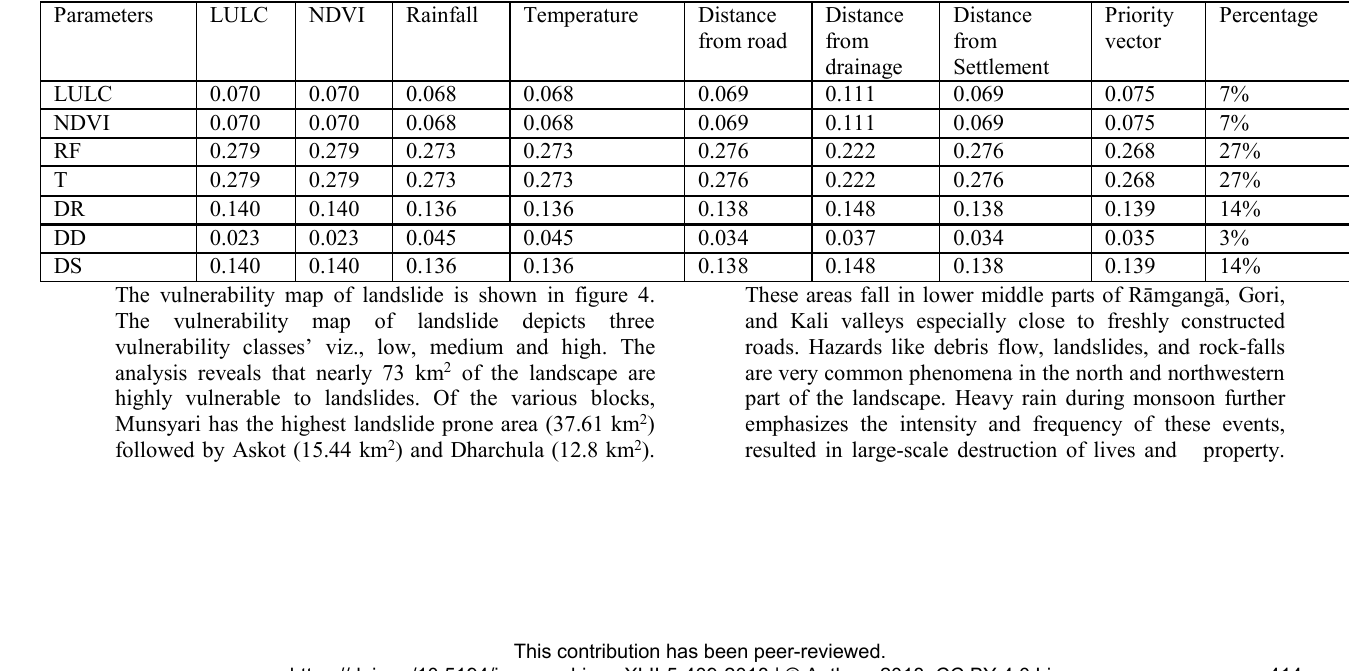
Table 8 Normalized forest fire parameters: Analytical Hierarchy Process